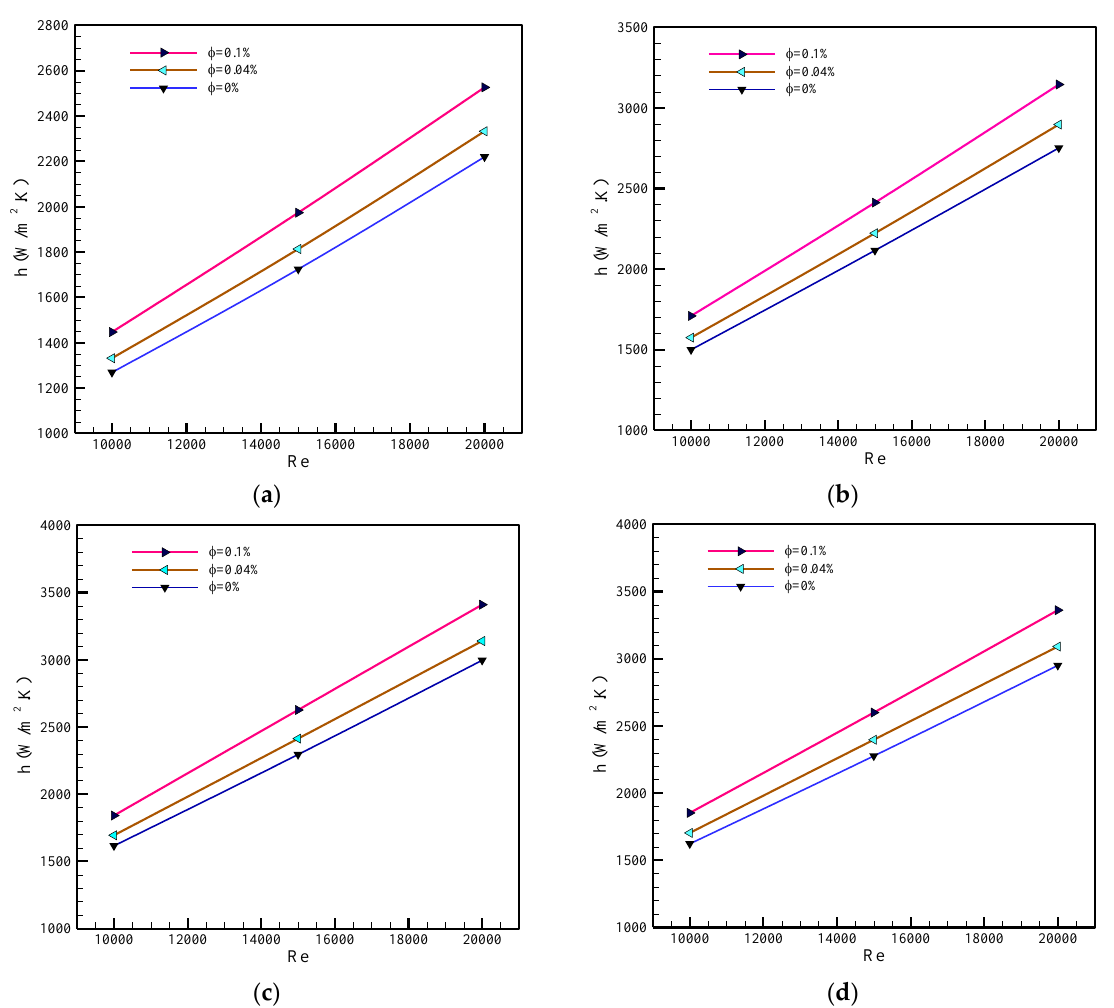
Figure 7. Heat transfer coefficient against Reynolds number at various solid volume fractions with baffle angles of ( a ) 45°, ( b ) 90°, ( c ) 135°, and ( d ) 180°.